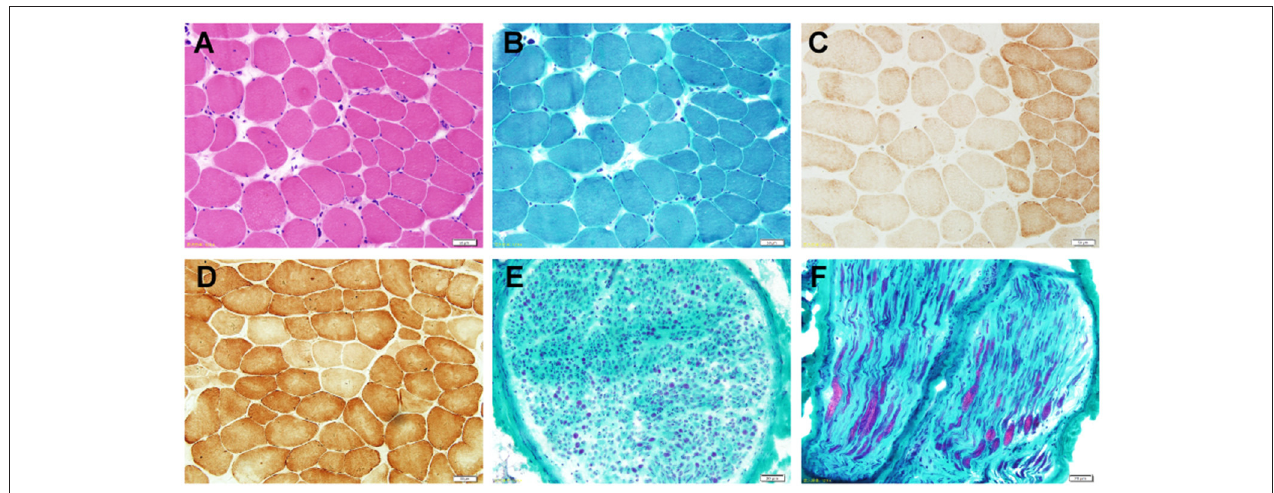
FIGURE 2 | Photomicrographs of the nerve and muscle biopsy of the proband. (A) Hematoxylin and eosin staining ( × 100) shows numerous angulated atrophic fibers with an angular shape and decreased size, indicating atrophic fibers and denervation atrophy. (B) MGT staining ( × 100) reveals no ragged red fibers. (C) COX staining ( × 100) reveals extremely lower COX activity. (D) COX ( × 100) staining showed a normal muscle sample from age-matched control. (E,F) Pronounced depletion of large myelinated fibers by approximately 80% in the MGT-stained sural nerve ( ×